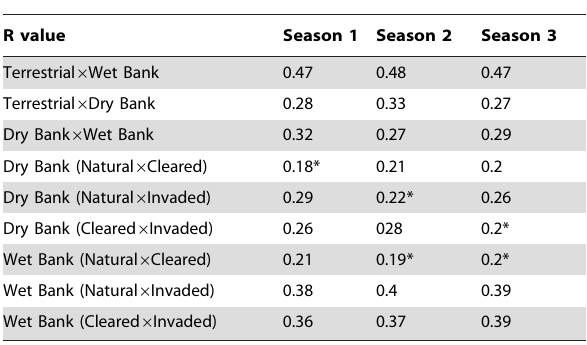
Table 2. R values of the ANOSIM comparisons made between hydrological zones and invasion status within dry bank and wet bank